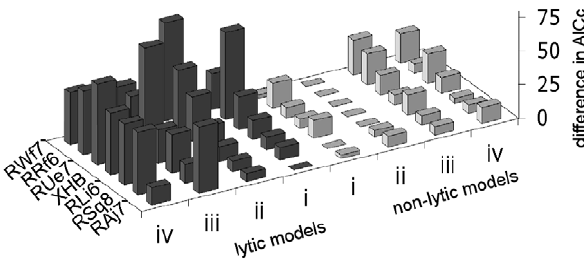
Figure 5. Comparison of lytic and non-lyic model fits. The AIC c of the model minus the AICs of the best fitting model for that animal is shown. A large difference represents a poor fit. Overall the model in which CD8 + T cells operate via a non-lytic mechanism which reduces infection offers the best fit in 6 out of 7 cases, a lytic model only offers the best fit in 1/7 cases. The 4 lytic models are i) the basic model ii) an extension of the basic model to include two populations of productively infected cells iii) a model following Klenerman et al in which SIV is cytopathic and iv) a model following Althaus et al in which CD8 + T cell killing is limited to the early non-productive stage of